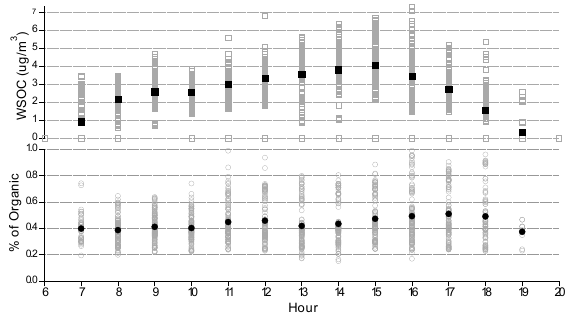
Fig. 5. WSOC magnitude (squares) and % of AMS organic (circles). Black markers represent the average over regime III.